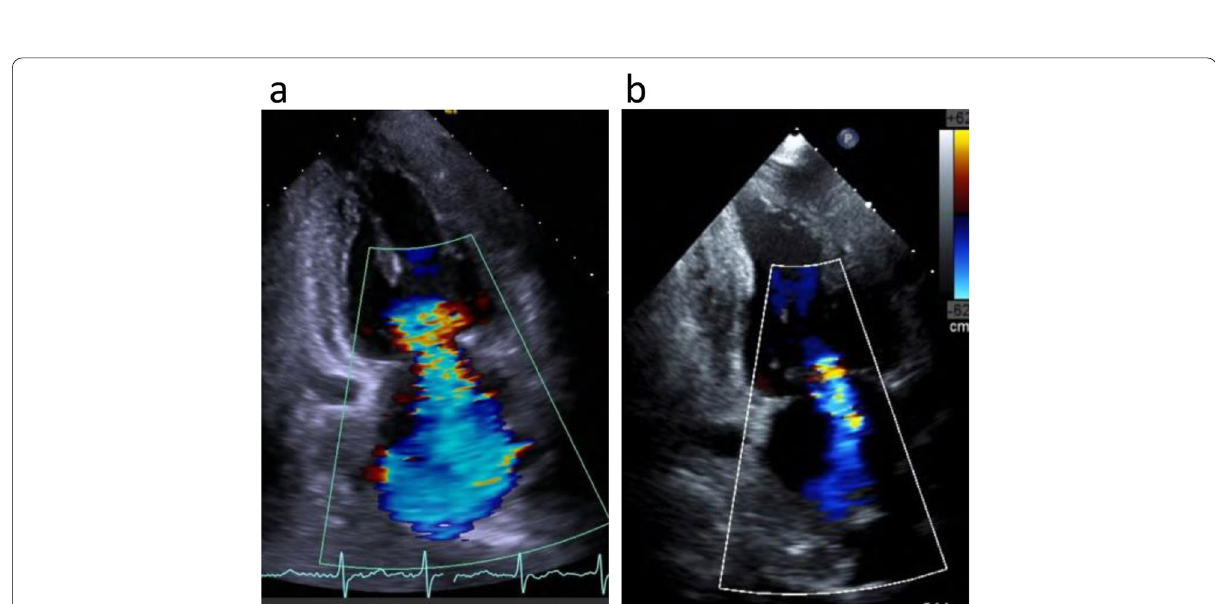
Fig. 2 Changes in cardiac function before ( a ) and after ( b ) living-donor renal transplantation by transthoracic echocardiography. Left ventricular ejection fraction, left ventricular end-diastolic diameter, and left ventricular end-systolic diameter were 30%, 57 mm, and 50 mm at the preoperative point ( a ) and 50%, 50 mm, and 38 mm at postoperative day 180 ( b ), respectively. Severity of mitral regurgitation, effective regurgitant orifice area (proximal isovelocity surface area), and tricuspid regurgitant pressure gradient were severe, 0.25 cm 2 , and 30 mmHg at the preoperative point ( a ) and mild, 0.12 cm 2 , and 21 mmHg at the postoperative day 180 ( b ), respectively. The above results show that the patient’s cardiac function and severe mitral regurgitation improved to a degree that indicated that cardiac surgery was no longer